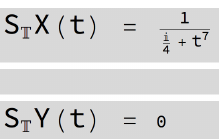
Figure 23. Output given by the [SInt] algorithm.